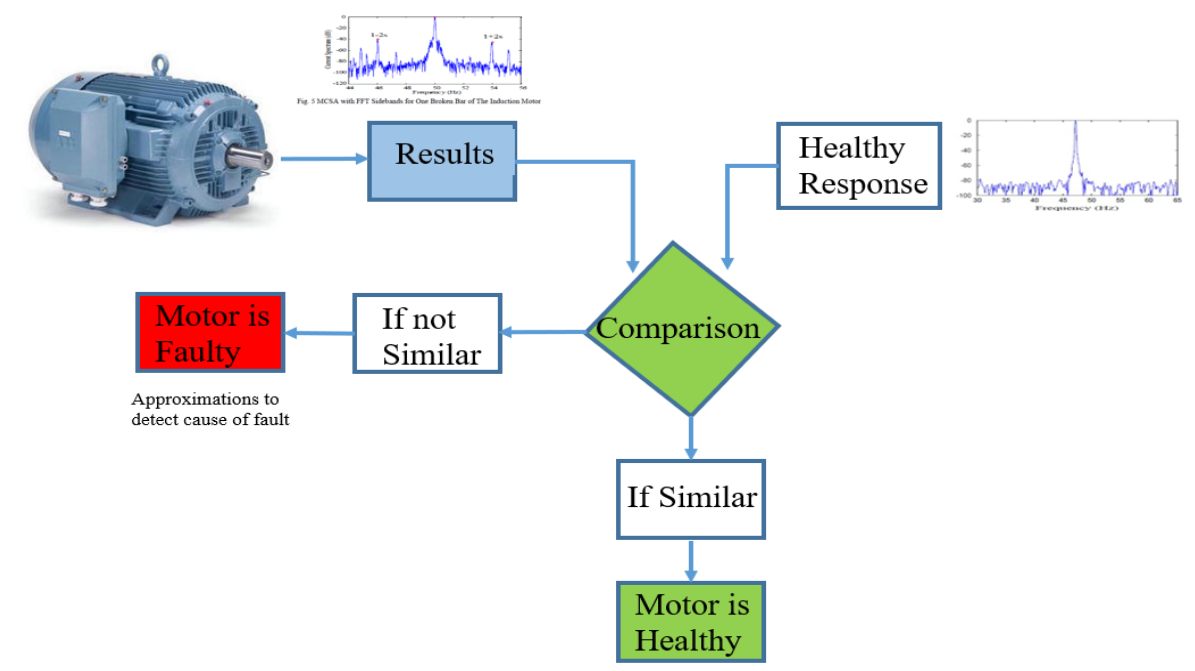
Fig. 3. Schematic diagram of the conventional forward model for fault diagnostics.